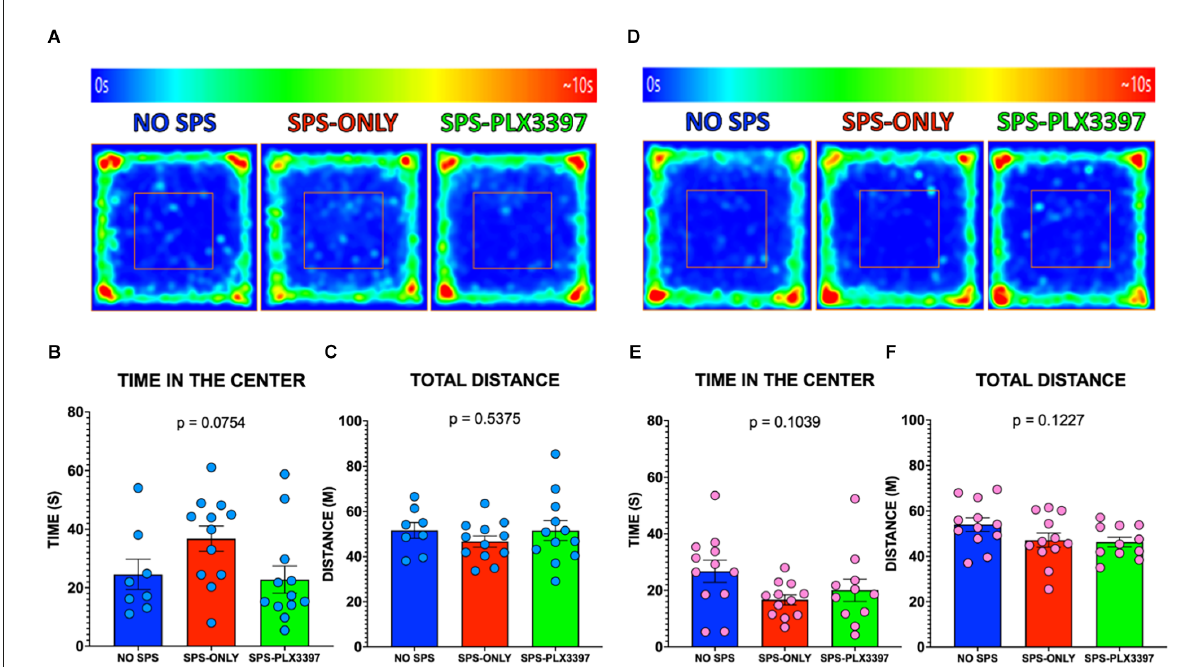
FIGURE2 Effects of oral PLX3397 on anxiety-like behaviors in male and female rats. (A) Average heat maps of the center of the body of the male group during the open field testing. (B,C) Graphs of the time in the center and total distance traveled for the male rats. (D) Average heat maps of the center of the body of the female group during the open field testing. (E,F) Graphs of the time spent in the center and total distance traveled in the OFT for female rats. One-way ANOVA, Tukey’s multiple comparisons test.